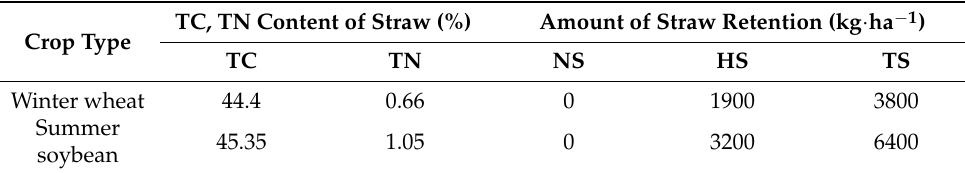
Table 1. Experiment design of different straw retention treatments. TC, TN Content of Straw Crop Type